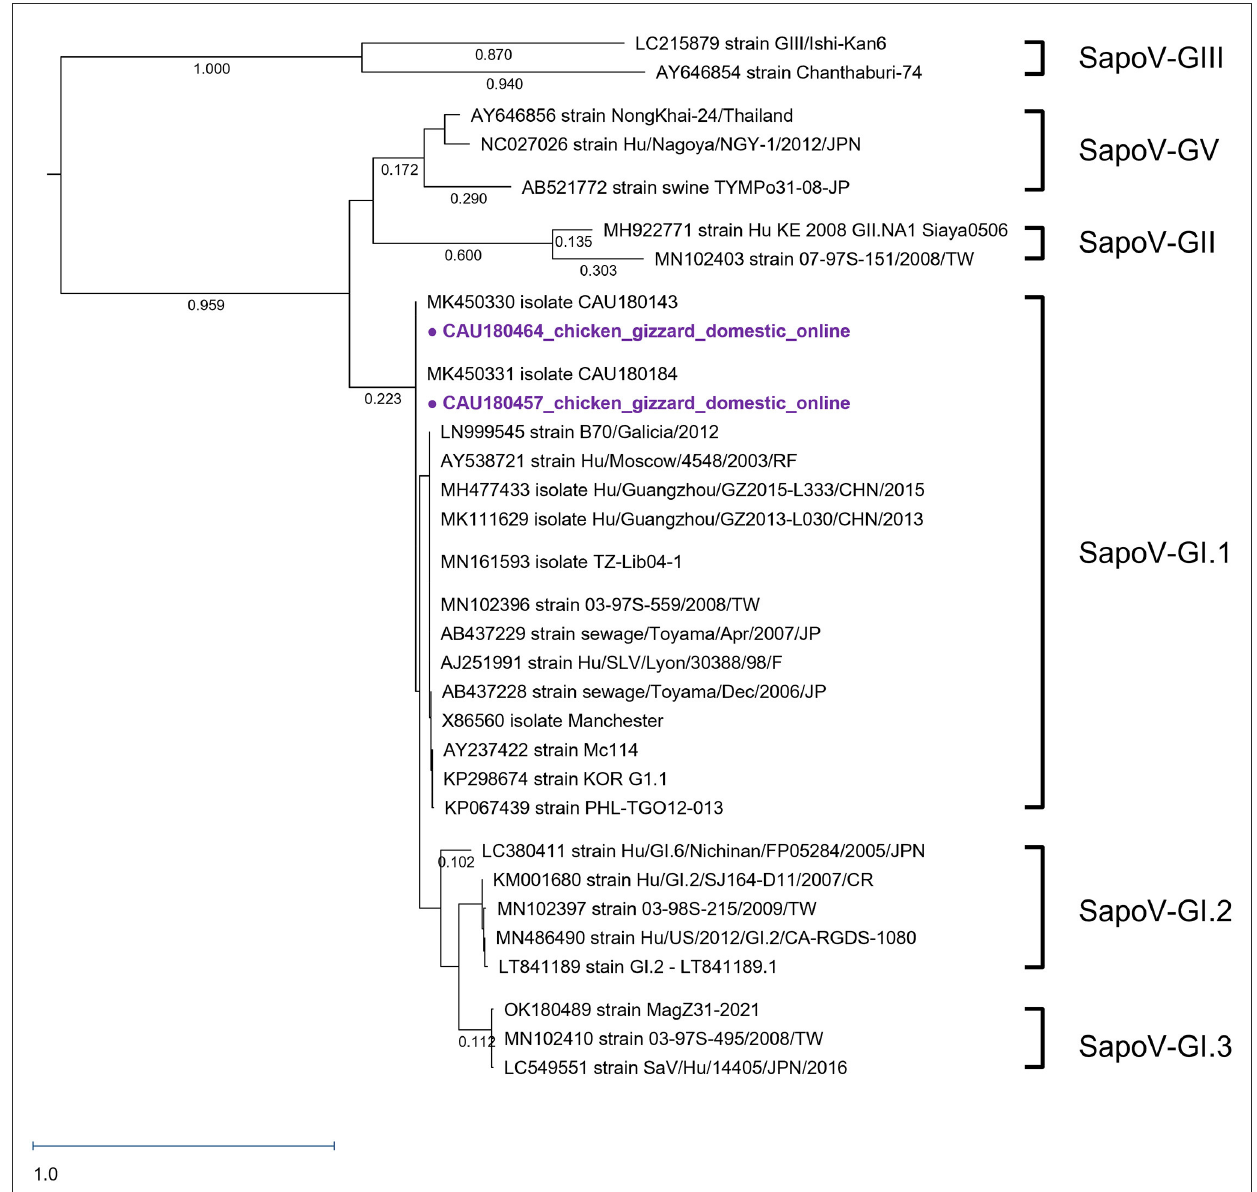
FIGURE3 Phylogenetic analysis of SapoV detected in chickens. The SapoV phylogenetic tree was constructed following the maximum likelihood method and based on 416-bp sequences of the VP1 region. The purple circles ( ) were AdV samples purchased in online markets. The numbers at the nodes of the tree indicate sequence